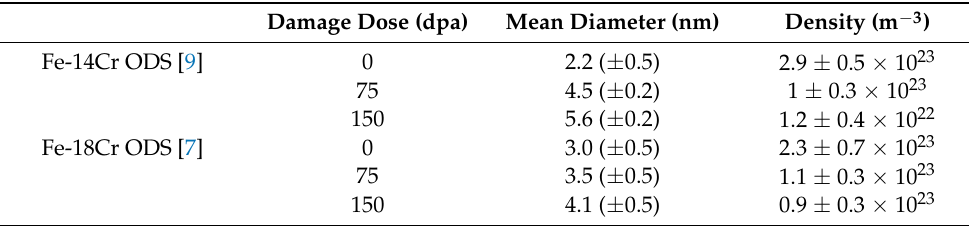
Table 6. Mean diameter and density of nano-oxides after ion irradiation in both Fe-14Cr ODS and Fe-18Cr ODS [7,9].